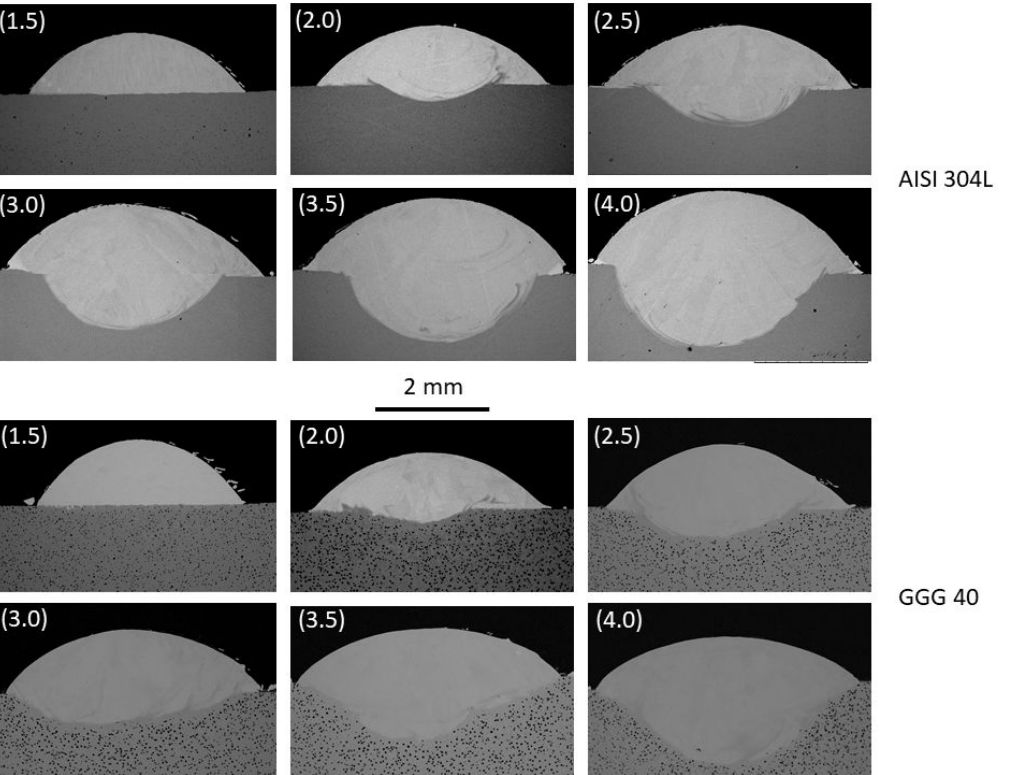
Figure 4. Hastelloy C276™ single beads macrography with the respective laser power (kW) and